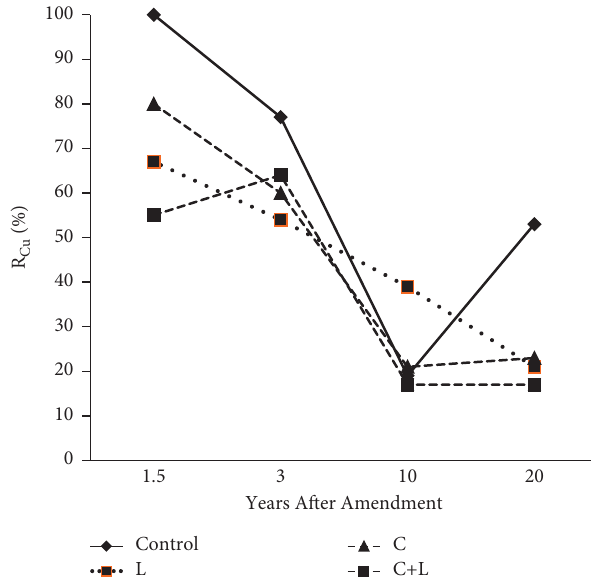
Figure 5: The relative concentrations of Cu ( R − 1 (HMP) (after Amirulloh � 100 x Cu/Cu Cu 0 -1.5) in topsoil amended with 60Mg waste ha and Salam (unpublished data, 2000) for 1.5 years, after [42] for 3 years, after [50] for 10 years, and after Susilowati and Salam (unpublished data 2018) for 20 years; the concentration of Cu in the topsoil of control at 1.5 years (Cu 0 -1.5) was 122mg · kg − 1 (L: lime at 5 Mg · ha − 1 ; C: cassava-leaf compost at 5Mg · ha − 1